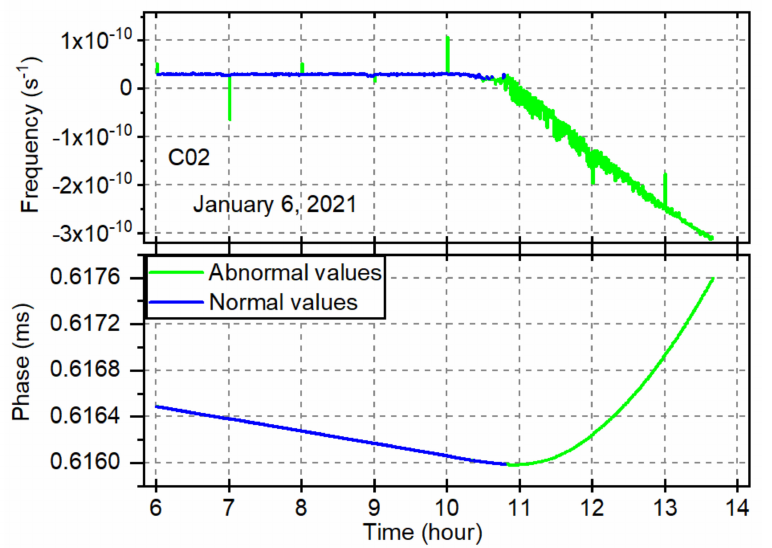
Figure 5. Frequency modulation on the C02 satellite and abnormal clock detection results in the fre- quency (top) and phase (bottom) domains. The frequency modulation causes the real-time estimated clock offsets to be unavailable after about UTC